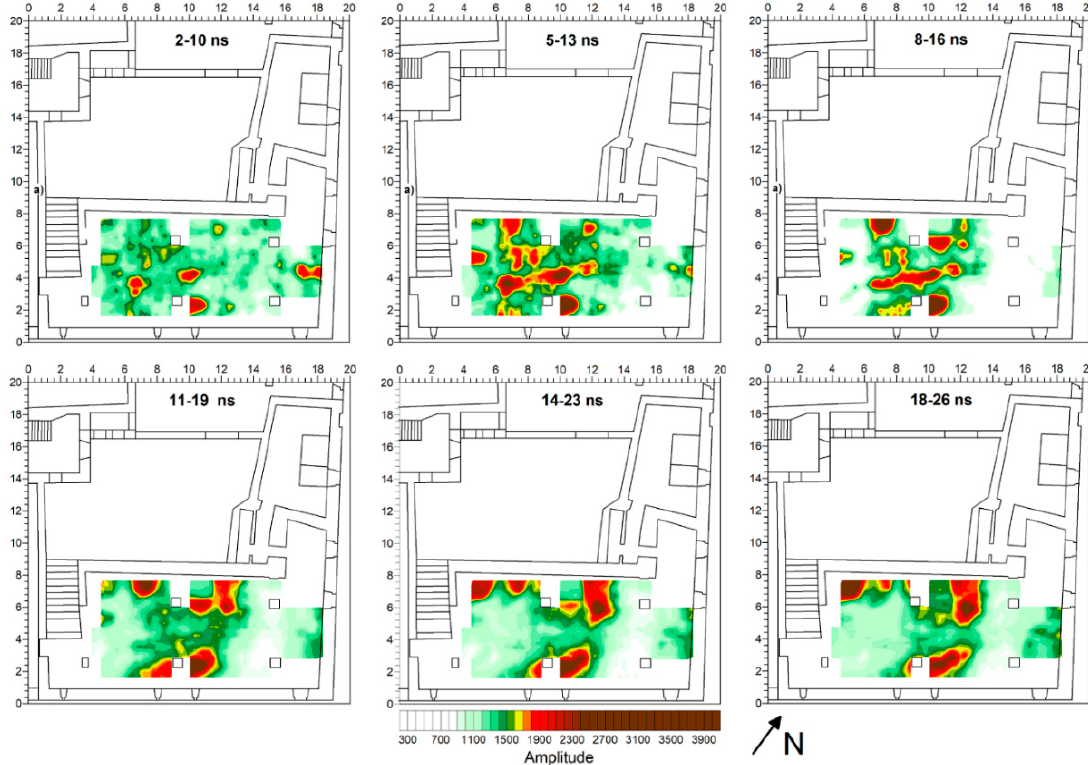
Figure 7. Time slices in the range 0–26 ns, distances in meters relative to the frequency of 600 MHz.